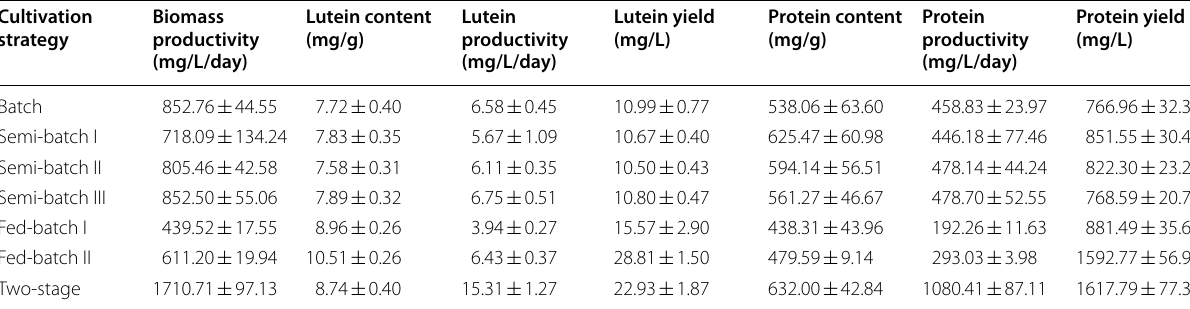
Table 1 Co‑production of lutein and protein in C. sorokiniana FZU60 under different cultivation strategies Cultivation